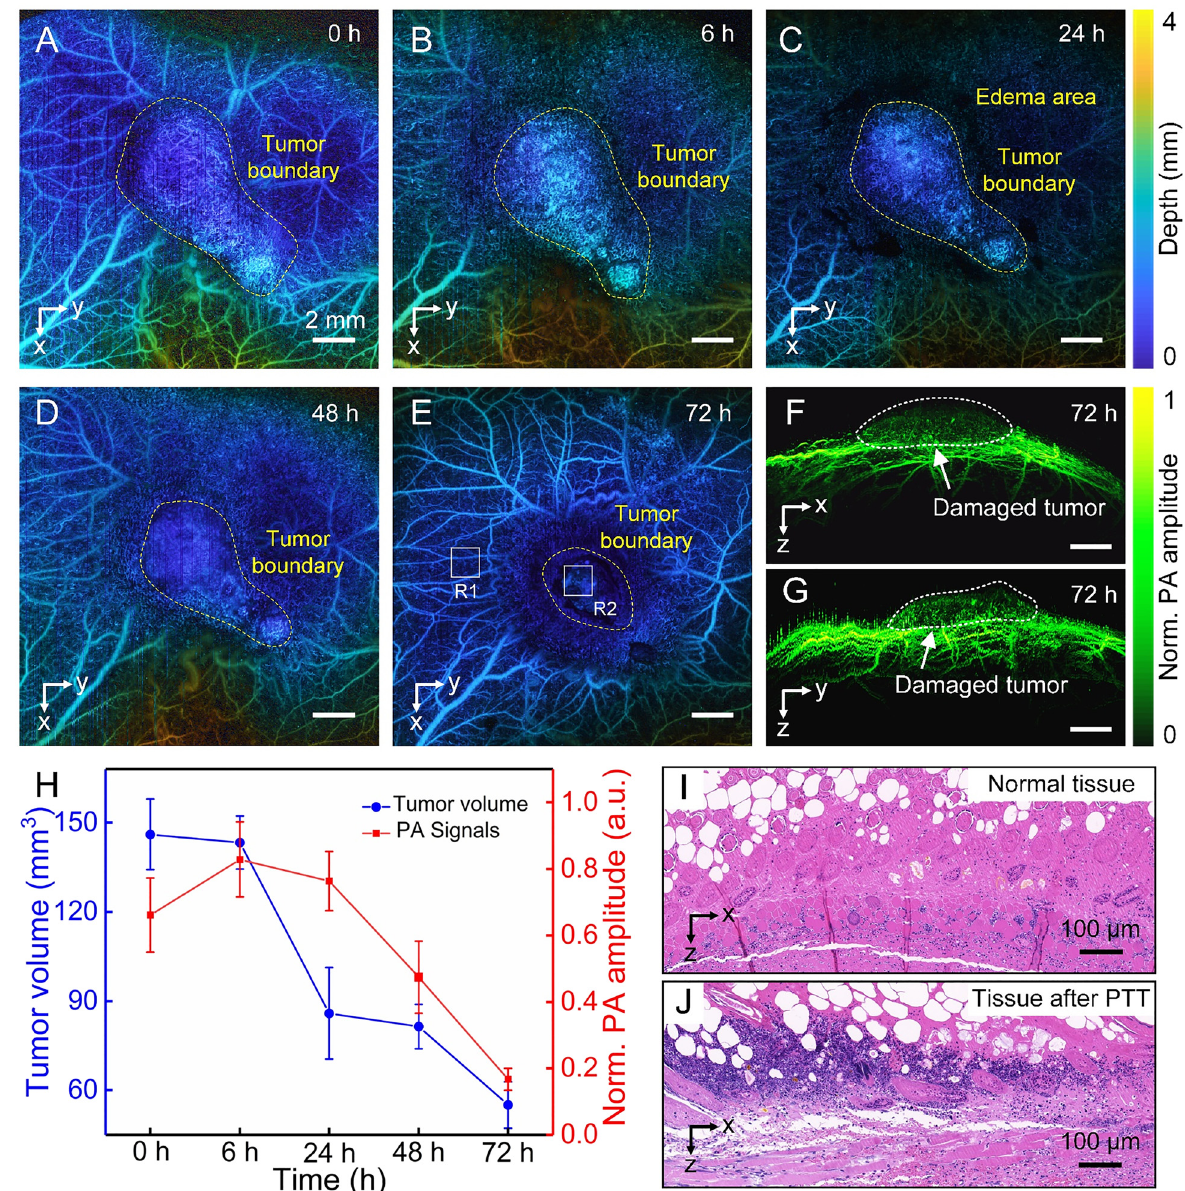
Figure 6: In vivo photothermal therapy after injection through the tail vein. (A) – (E) The microvasculature was imaged at different timing to evaluate the therapeutic effect. (F) and (G) The tomographic projection images of the tumor regionat 72 h aftertreatment.(H) Tumorvolumes and PA signalsamplitudeat different timingafter treatment.(I) Image with H&E staining histopathology of normal tissue around the tumor (R1) in Figure E. (J) Image with H&E staining histopathology in tumor site (R2) in Figure